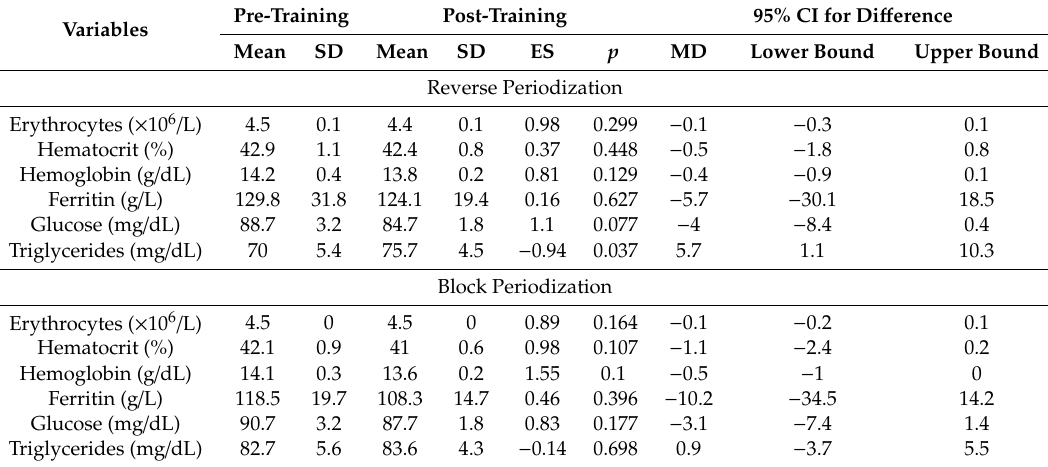
Table 2. Hematological results in both